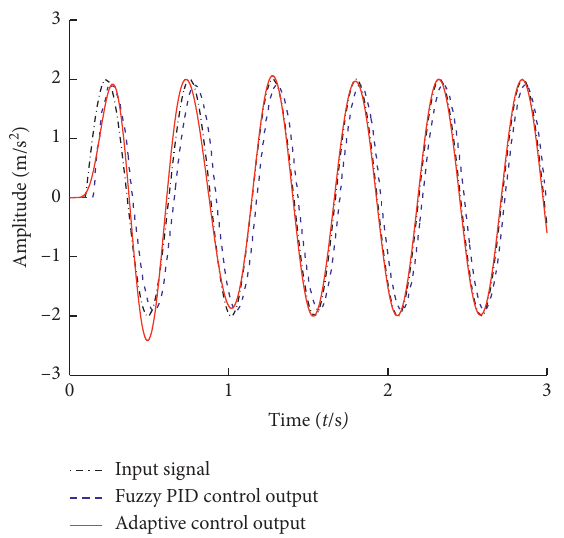
Figure 10: Sine signal before and after control.